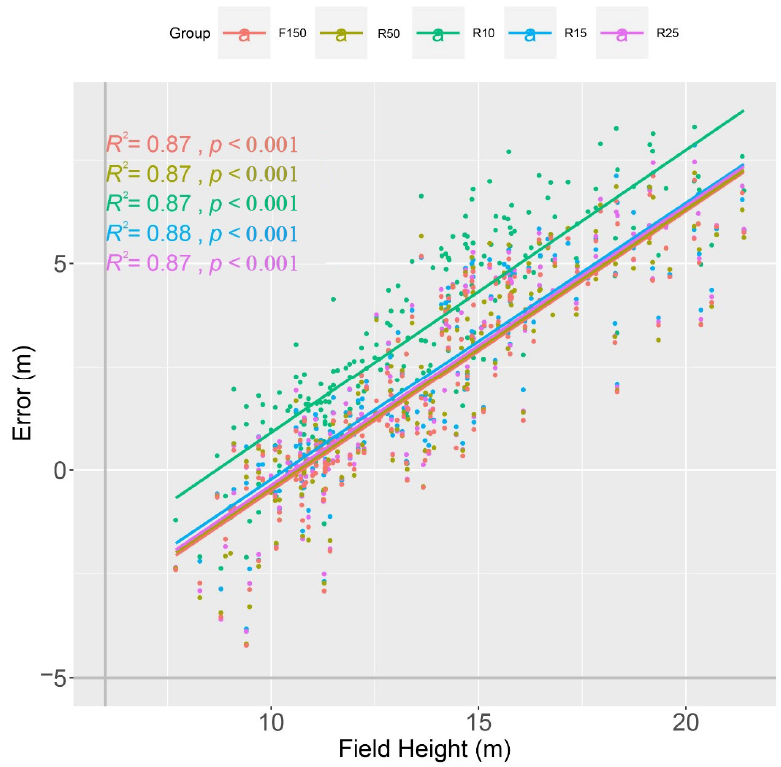
Figure 6. Correlation between the error (difference between the height of D. pierrei measured in the field survey and the height of D. pierrei obtained from different point cloud densities) and the height of D. pierrei measured in the field survey. A comparison of the accuracy of D. pierrei height extraction under different vegeta- tion types (Figure 7), obtained using the five point cloud densities, showed that the accu- racy of D. pierrei height varied among the different vegetation types, and the D. pierrei height difference was the largest under R15 (RMSE% = 3.63%). In summary, the accuracy of D. pierrei height acquisition was higher in coniferous forests. Irrespective of coniferous or broad-leaved forests, as the point cloud density increased, the accuracy of D. pierrei height extraction also gradually increased (Figure 7), and the difference in the accuracy of D. pierrei height between different stands also gradually increased (Figure 8). It is worth noting that after the point cloud density reached R15, the accuracy of the extracted D. pierrei height was not significantly different. By analyzing the D. pierrei height accuracy of R15, R25, R50, and F150 relative to R10 (Figure 9), we can see that with the increase in point cloud density, the accuracy of the D. pierrei height extracted from the coniferous forest increased further.